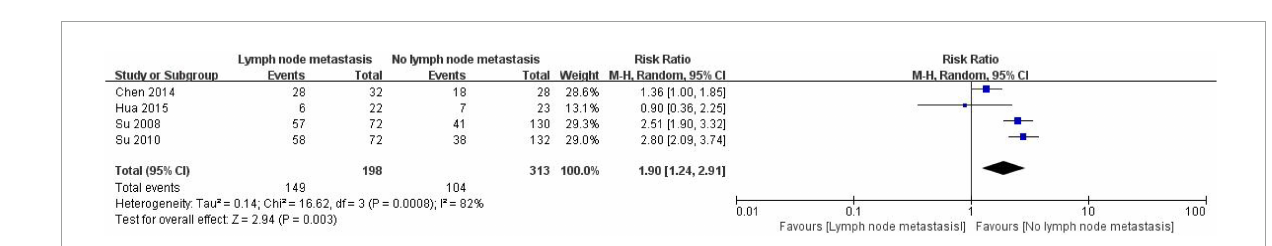
FIGURE3 Forest map of correlation between CD24 expression and lymph node metastasis.